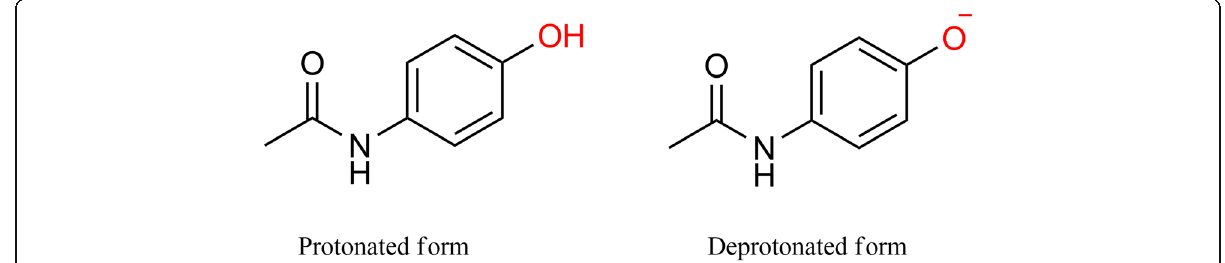
Fig. 4 Protonated and deprotonated form of ACT